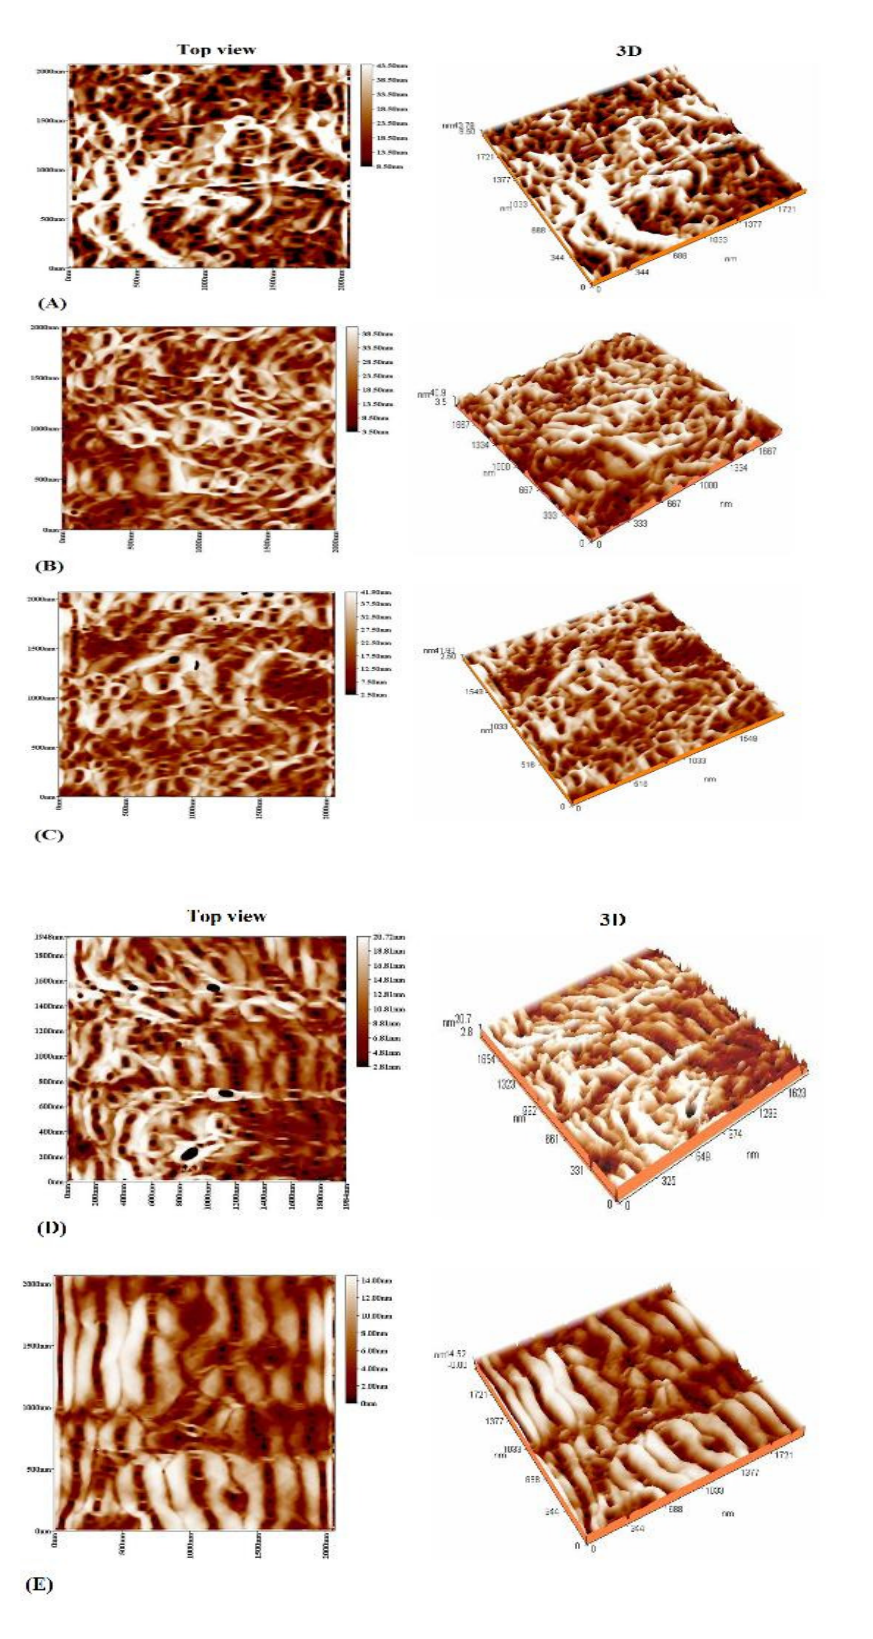
Fig. 3. Three-dimensional and top view AFM pictures of the outer surface of the hollow fiber blend membranes: (A) PS1, 1 wt.%, (B) PS2, 2 wt.%, (C) PS3, 3 wt.%, (D) PS4, 4 wt.%, (E) PS6, 6